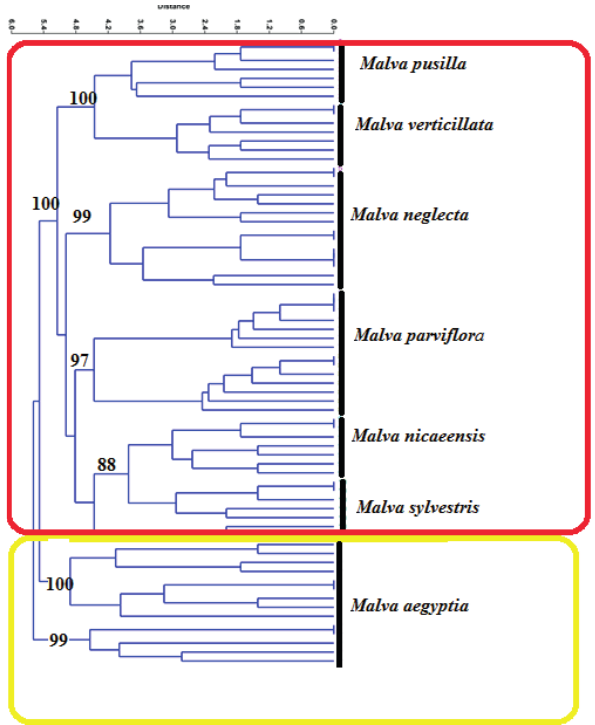
Figure 2. UPGMA clusters of morphological characters revealing species delimitation in Malva